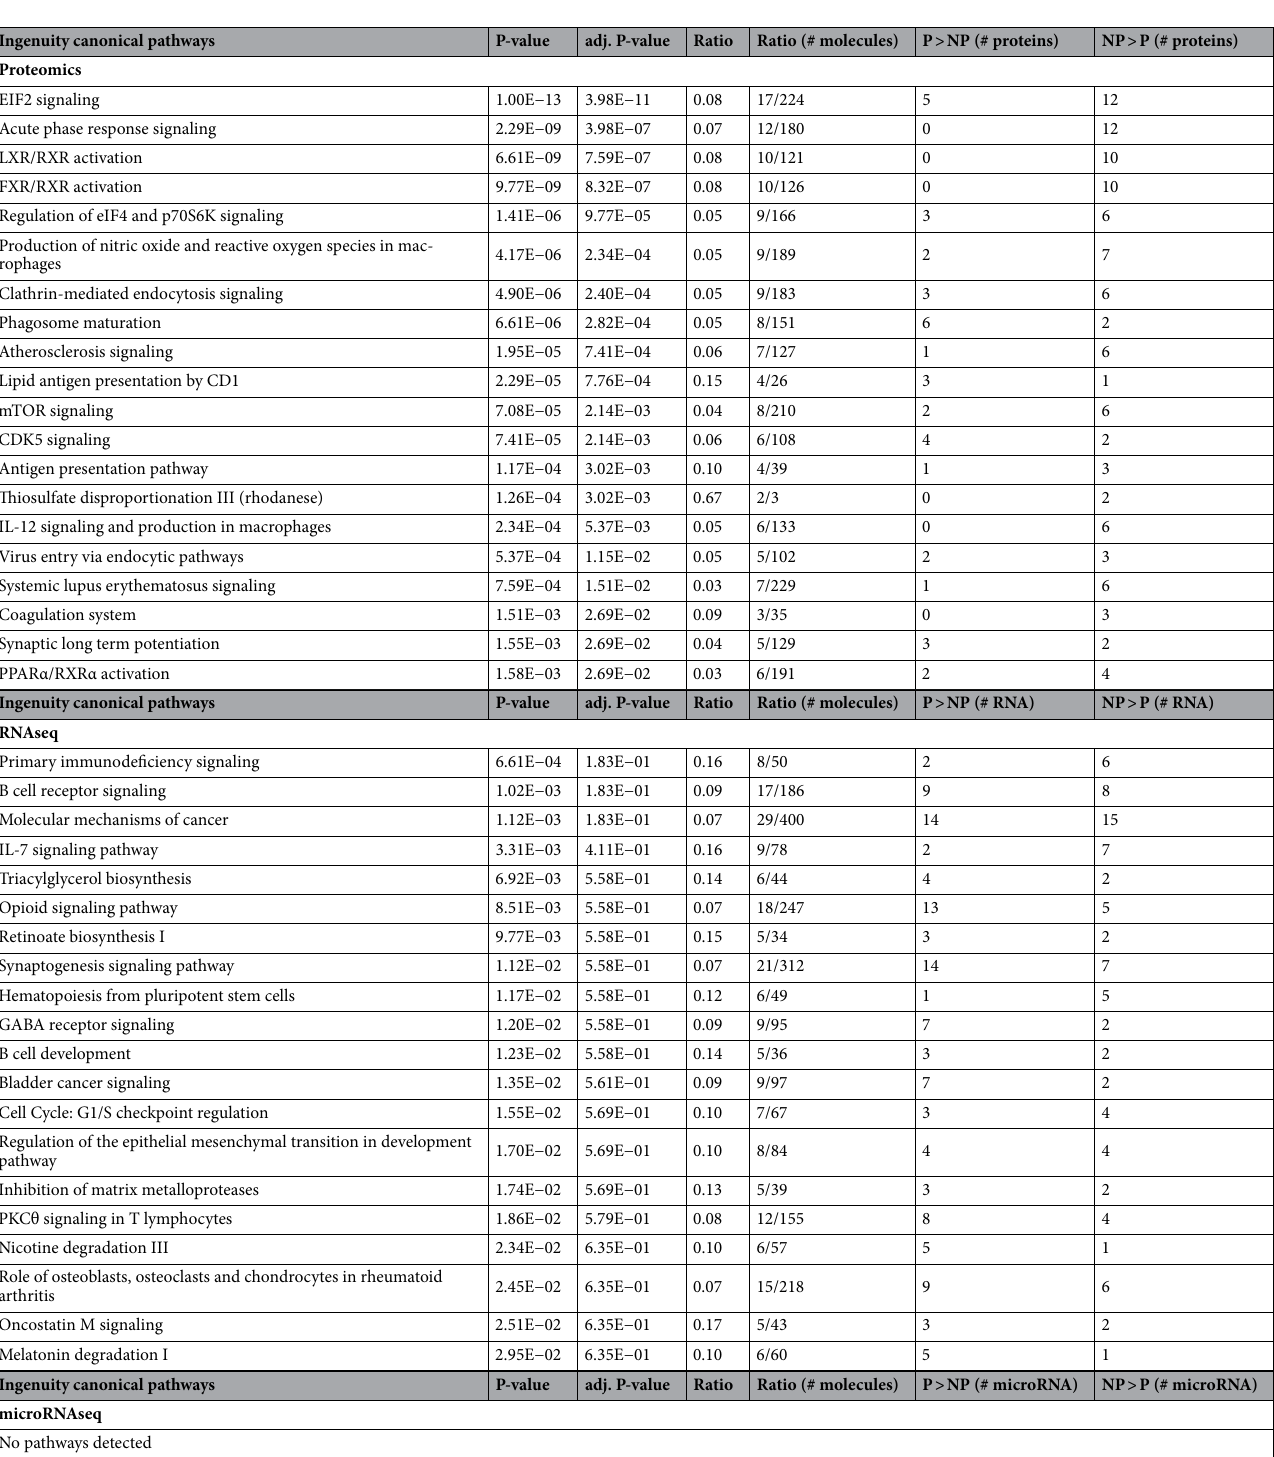
Table 2. Twenty pathways from each dataset, sorted by increasing p- values. P progressor, NP